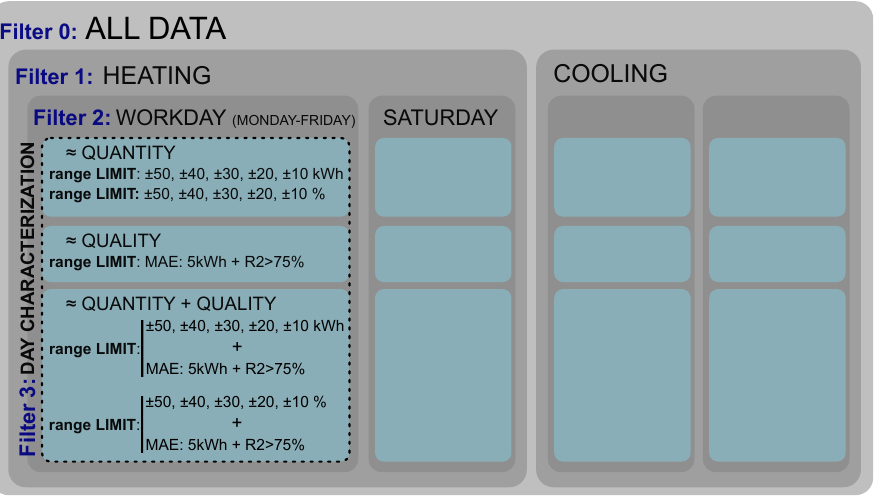
Figure 4. Hierarchy of filters proposed for the selection of the training